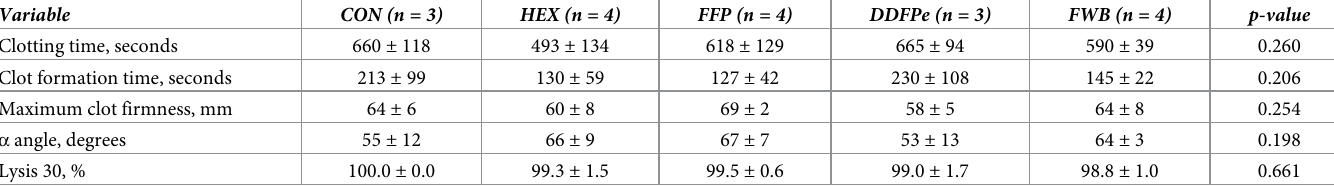
Table 2. Viscoelastic properties of